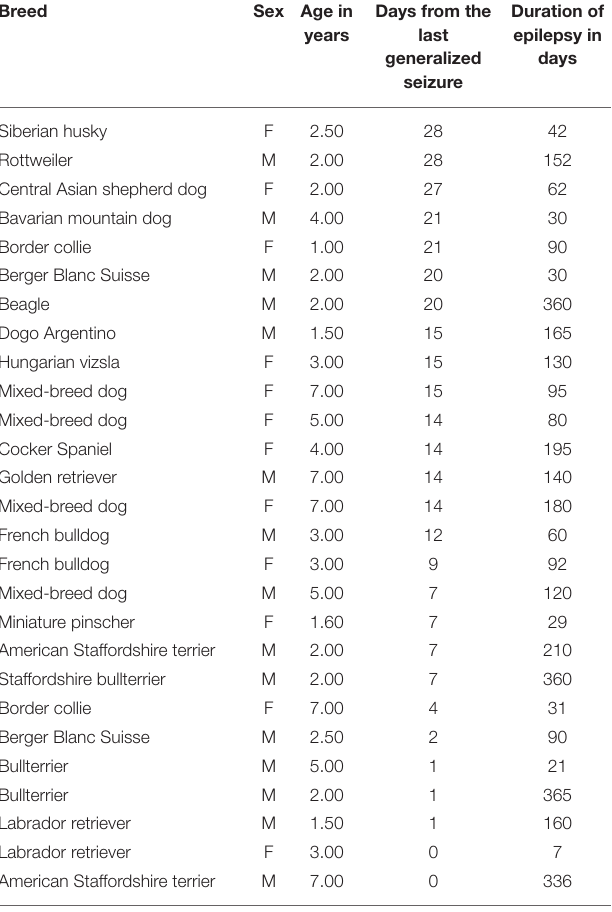
TABLE 1 | Number of different breed dogs comprised in the idiopathic epilepsy group. Breed Sex Age in